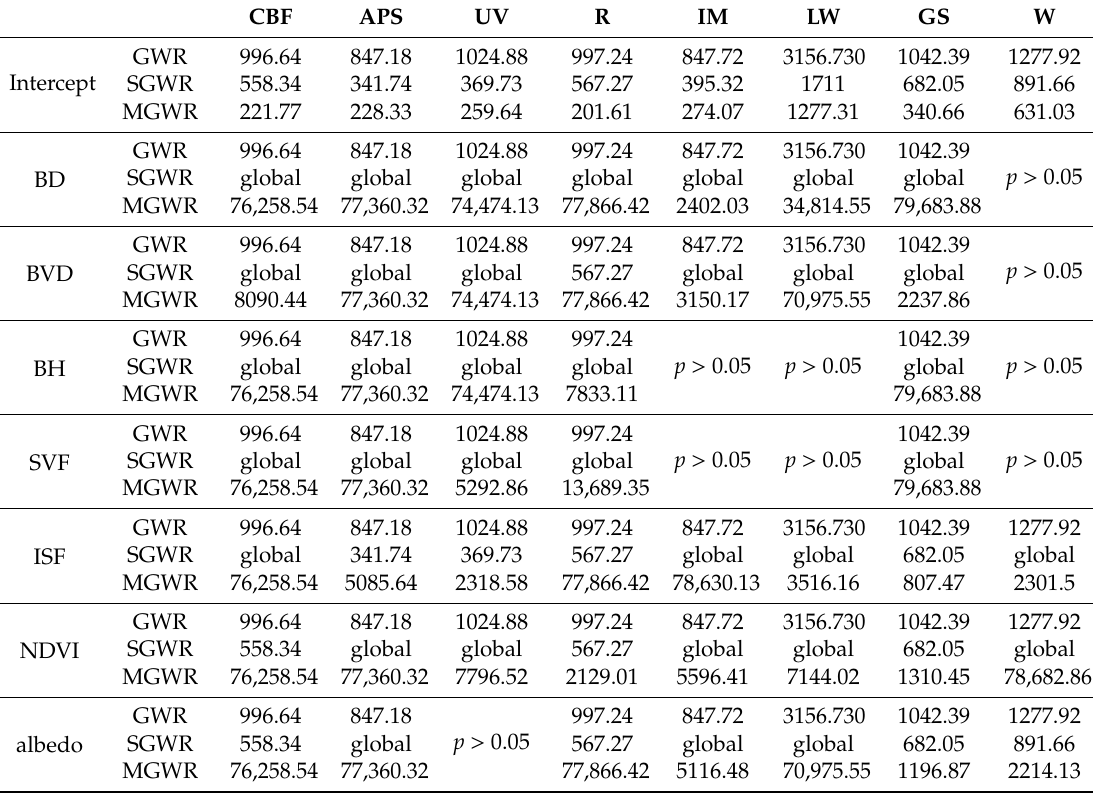
Figure 8. The slope coe ffi cients of BD to LST by SGWR. Table 7. Optimal bandwidths identified by GWR, SGWR, and